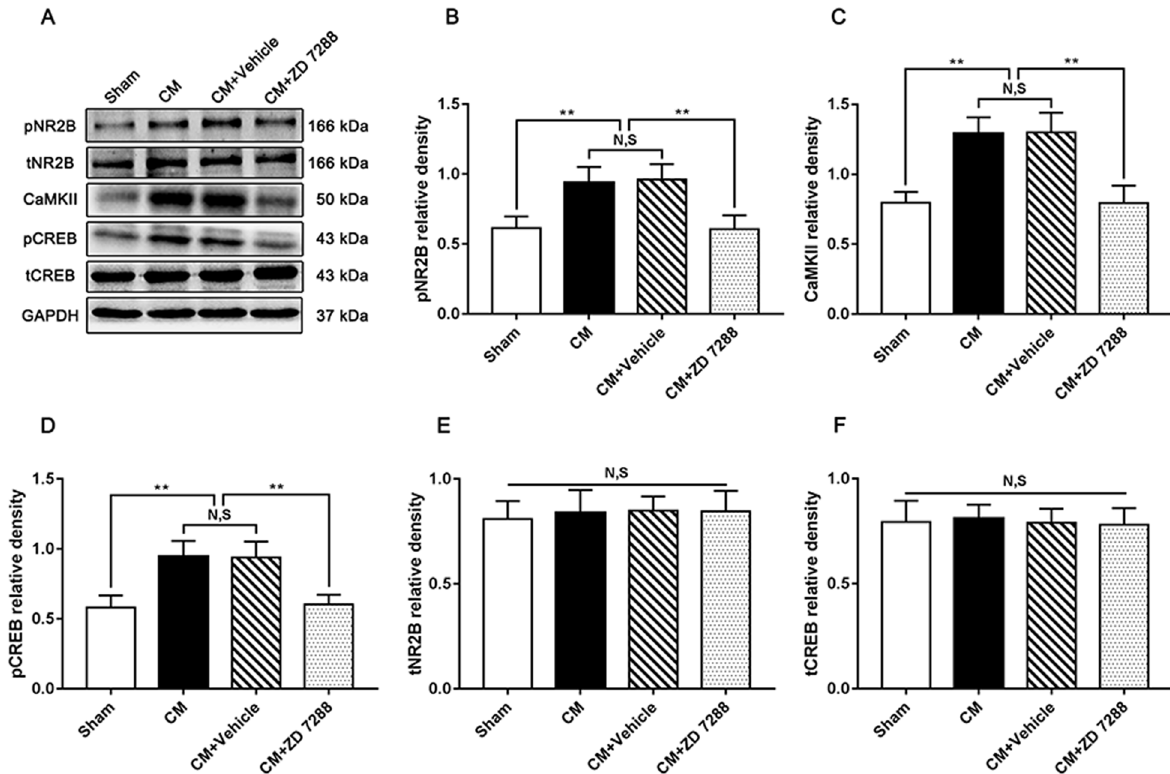
Fig. 7 The effect of ZD 7288 on the pNR2B/CaMKII/pCREB pathway in CM rats. A Representative western blots of pNR2B, CaMKII, pCREB, tNR2B, and tCREB. B-D Compared with the Sham group, the levels of pNR2B, CaMKII, and pCREB in the CM group were profoundly elevated, and there was no change between CM and CM Vehicle groups. Compared to the CM Vehicle group, the levels of pNR2B, CaMKII, and pCREB in the CM + + 7288 group were visibly decreased. ( n 6/group, ** p < 0.01, N, S, not significant). E and F There was no significant difference in tNR2B and tCREB = expression among the Sham, CM, CM Vehicle, and CM ZD 7288 groups. ( n 6/group, N, S, not + + =